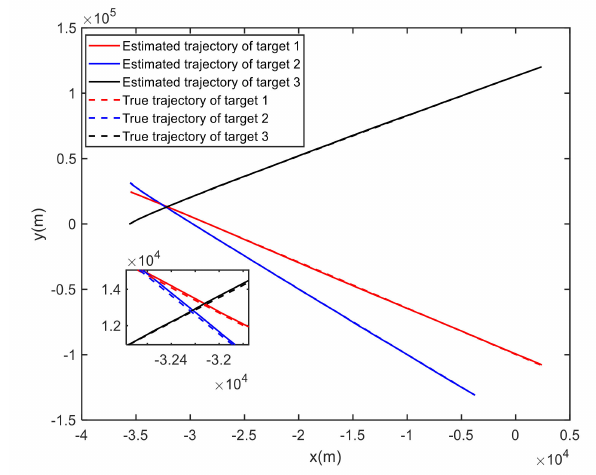
Figure 15. Comparison of the position errors for Target 3 in Case 1.